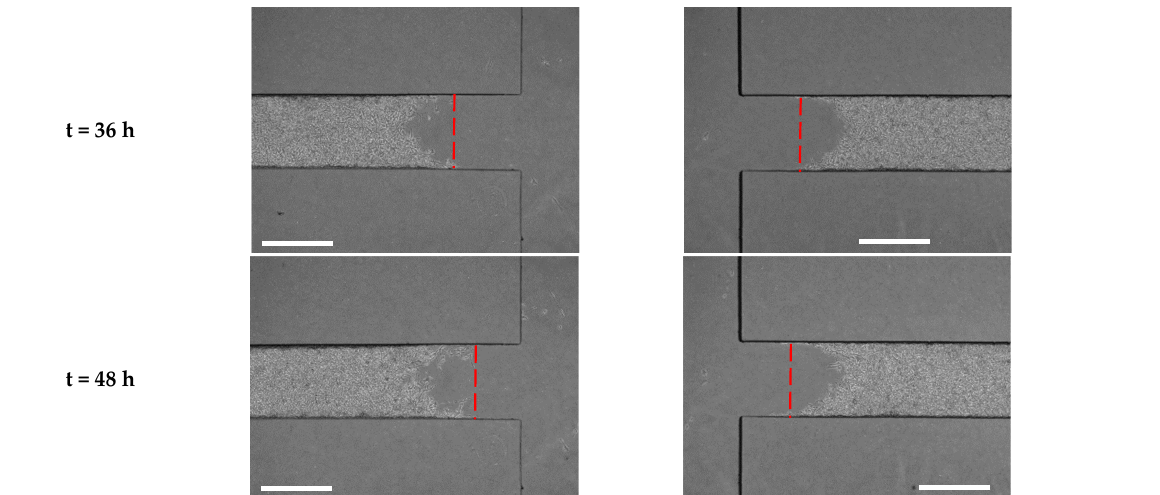
Figure 7. Time-lapse images from cell migration on the substrates of ( A ) PLL, ( B ) gelatin, ( C ) fibron- ectin, ( D ) collagen after 0, 12, 24, 36 and 48 h, scale bar = 600